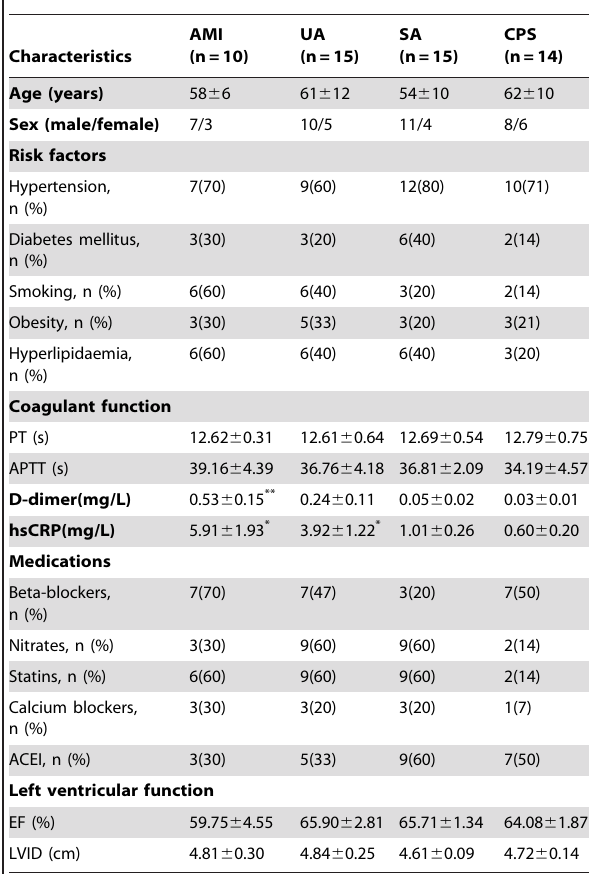
Table 1. Clinical characteristic of